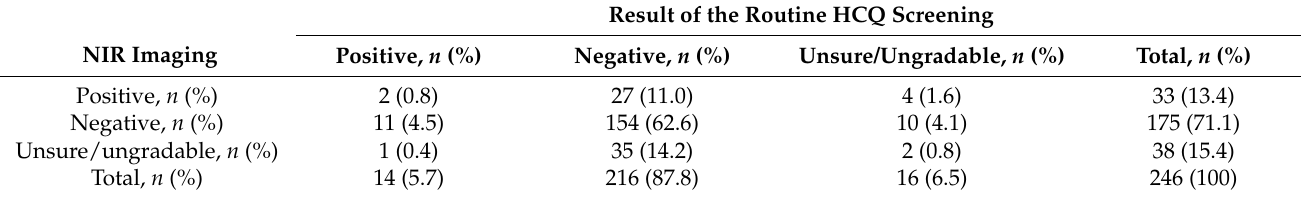
Table 2. Detection of eyes with bull’s eye maculopathy using NIR imaging compared to result of the routine HCQ screening result. Result of the Routine HCQ Screening